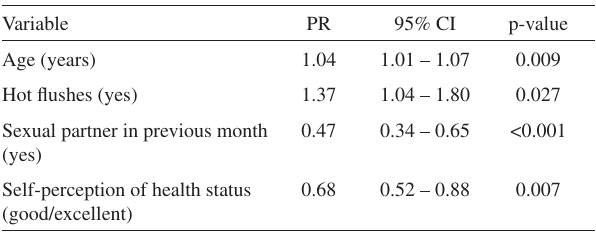
Table 2 - Variables associated with sexual dysfunction